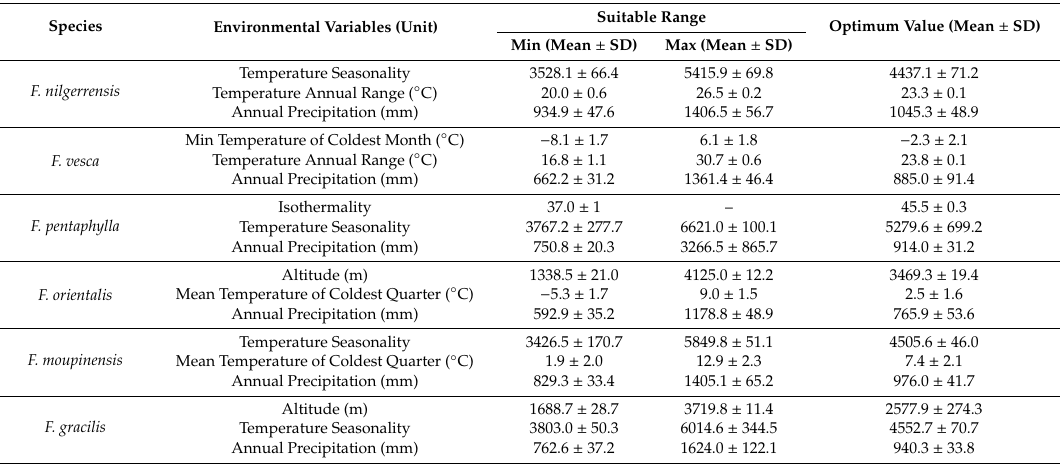
Table 2. Suitable ranges of critical environmental variables for the six wild strawberry species under the current climate